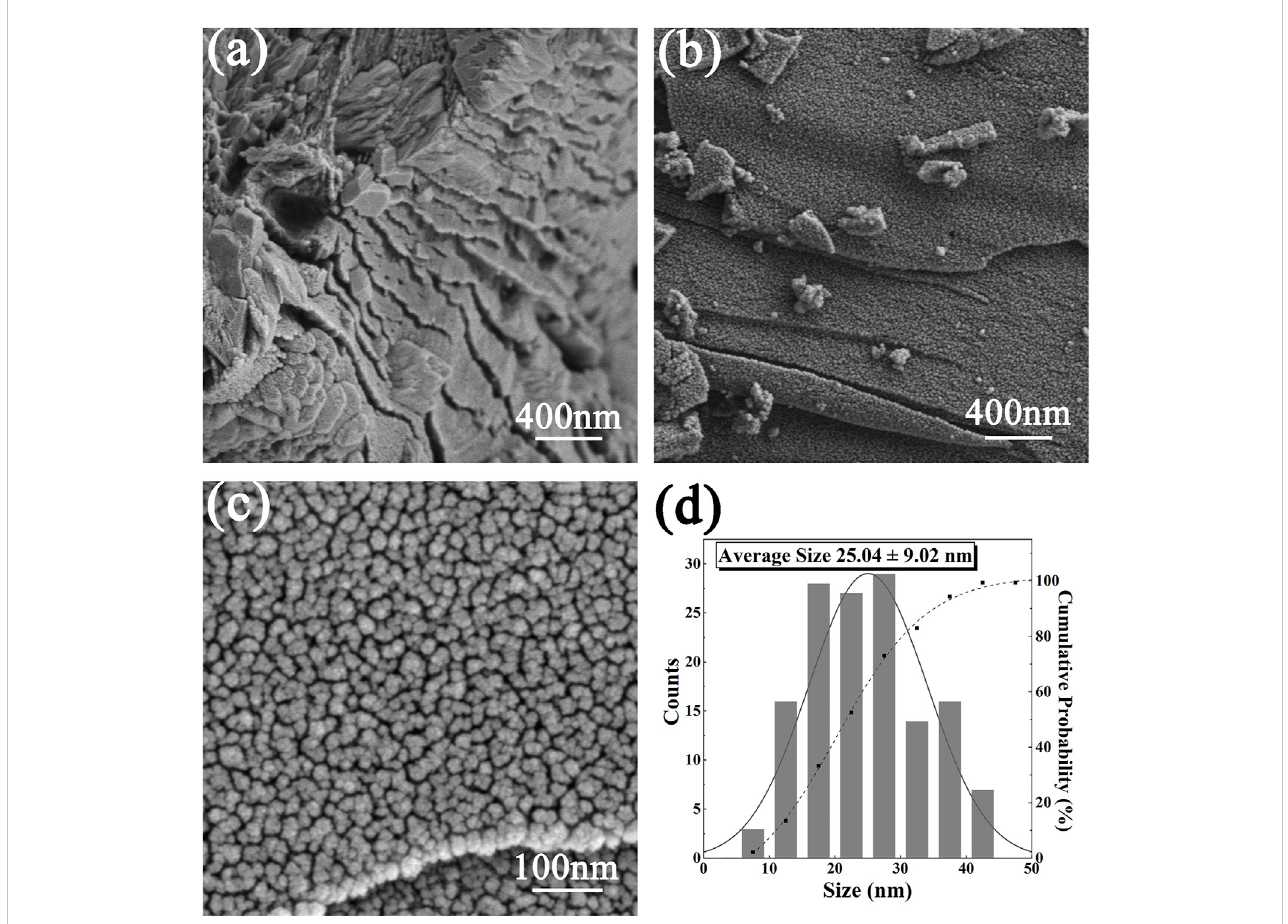
FIGURE 2 SEM micrographs of different samples: Modi fi ed oyster shell powder (A) , CeNT@Oys with different magni fi cation (B, C) ; particles analysis for Ce-N-TiO 2 (D) [done by ImageJ (v 1.52)